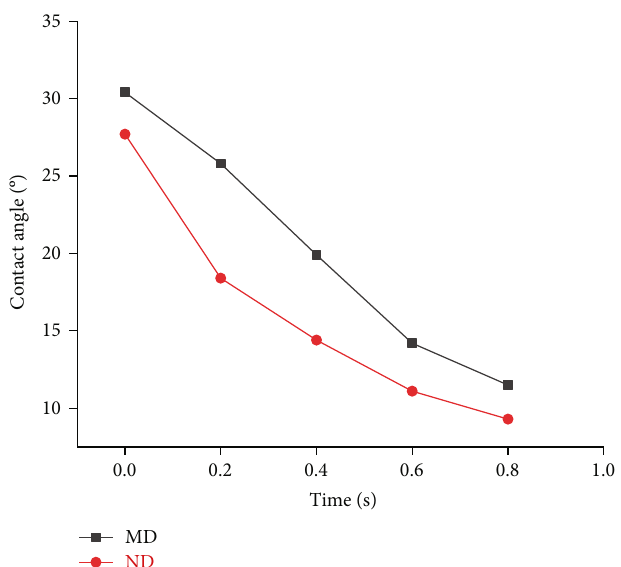
Figure 3: Changes of contact angle with